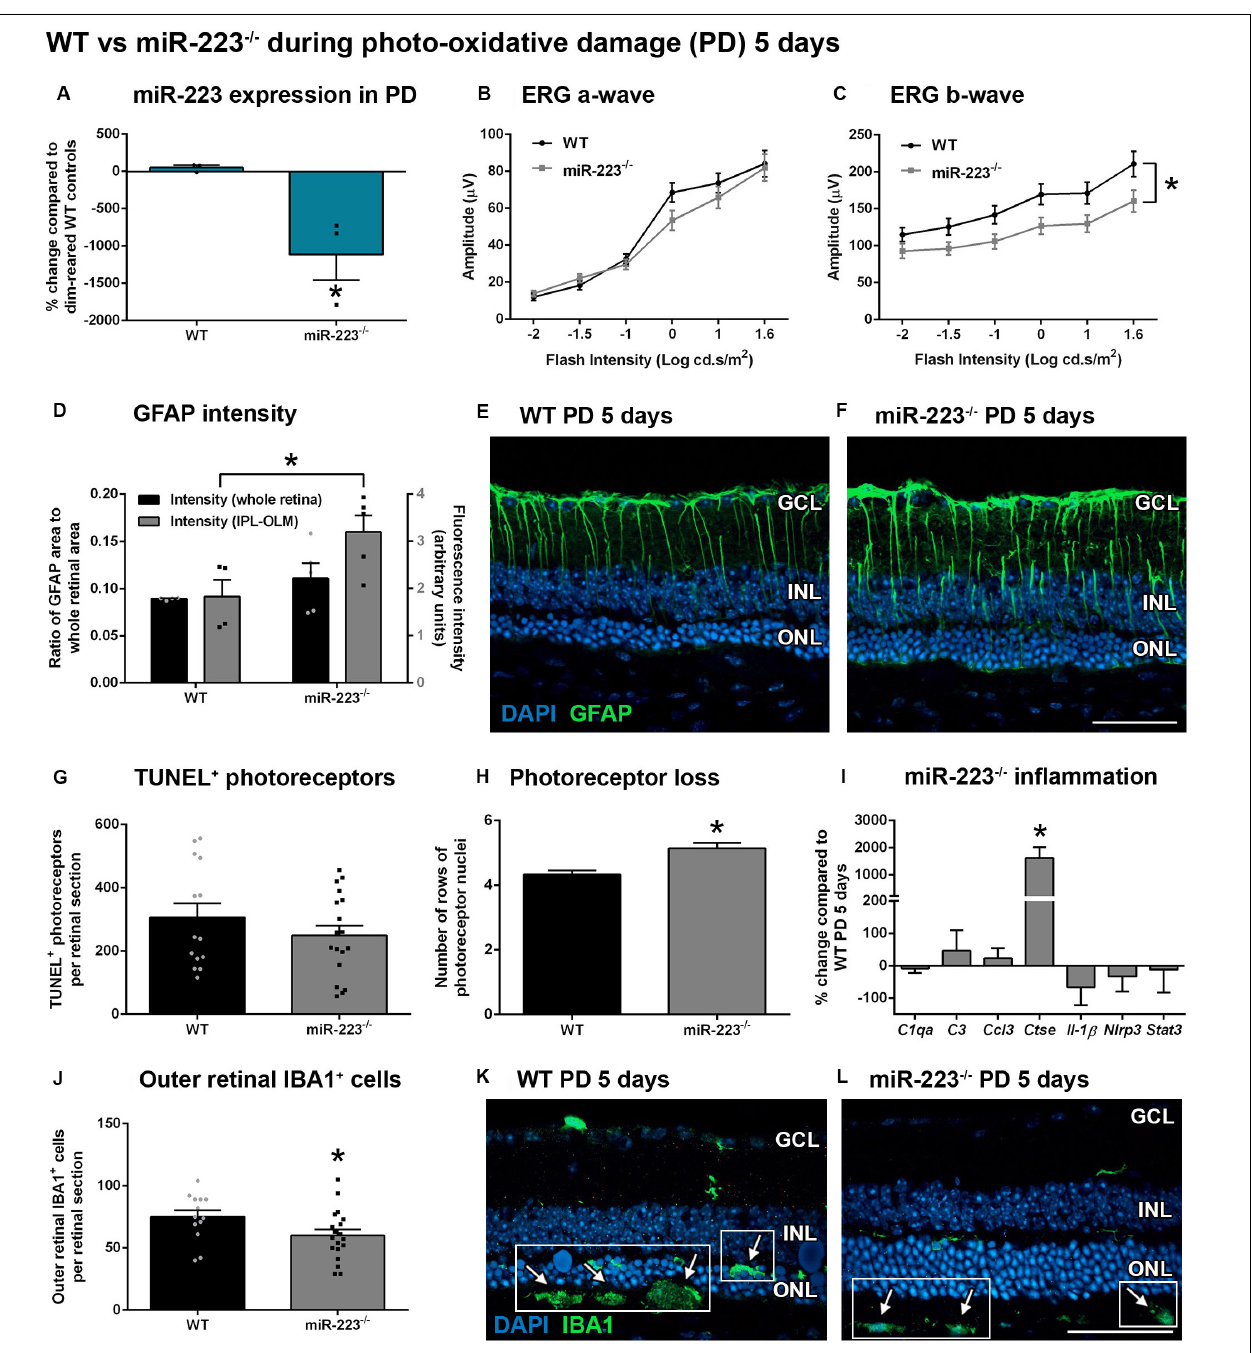
FIGURE 3 | Retinas of wild-type (WT) and miR-223 − / − mice during 5 days of photo-oxidative damage (PD). (A) miR-223 − / − mice were again confirmed to have a significant reduction in retinal miR-223 expression compared to WT mice ( P < 0.05). (B,C) Electroretinography (ERG) demonstrated that there was no change in the a-wave [ (B) , P > 0.05], but a significant change in the b-wave [ (C) , P < 0.05] in miR-223 − / − mice compared to WT controls. (D–F) GFAP intensity (green) was higher in all layers between the IPL and the OLM of miR-223 − / − retinas compared to WT retinas ( P < 0.05). Units for whole retinal GFAP on left Y -axis (black) and units for IPL to OLM GFAP on right Y -axis (gray). (G) No change in TUNEL was observed between groups ( P > 0.05). (H) miR-223 − / − retinas had more photoreceptor cell rows than WT retinas ( P < 0.05), indicating less cumulative photoreceptor death. (I) Ctse retinal expression was significantly increased in miR-223 − / − retinas compared to WT controls ( P < 0.05); however, no changes in any other inflammatory genes assayed were observed ( P > 0.05). (J–L) miR-223 − / − retinas had a significant reduction in IBA1 + (green) microglia and macrophages in the outer retina (arrows, white boxes), compared to WT controls ( P < 0.05). These were mainly present in the subretinal space. In WT animals, IBA1 + cells were increased in number and situated closer to the photoreceptor layer (arrows, white boxes). IPL, inner plexiform layer; OLM, outer limiting membrane; GCL, ganglion cell layer; INL, inner nuclear layer; ONL, outer nuclear layer. Scale bar is 50 µ m. Sample size is N = 3–9. *Denotes significance ( P < 0.05).